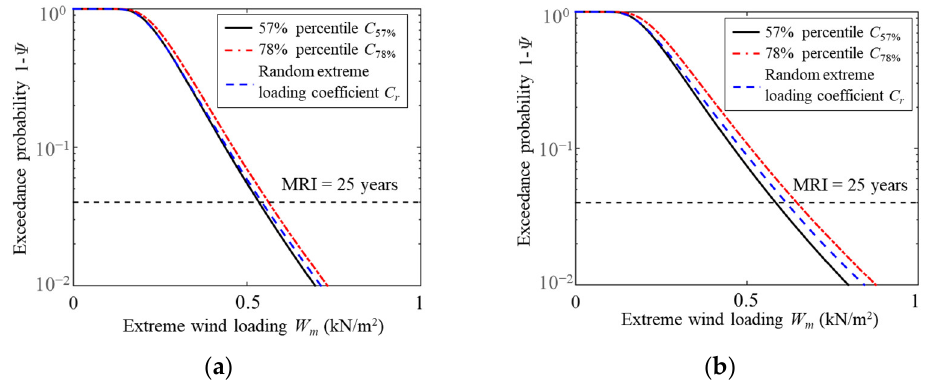
Figure 7. Exceedance probability of extreme wind loading W m on representative solar modules with building orientation α =0° in Jinan, China: ( a ) Module (1–4); ( b ) Module (4–8).